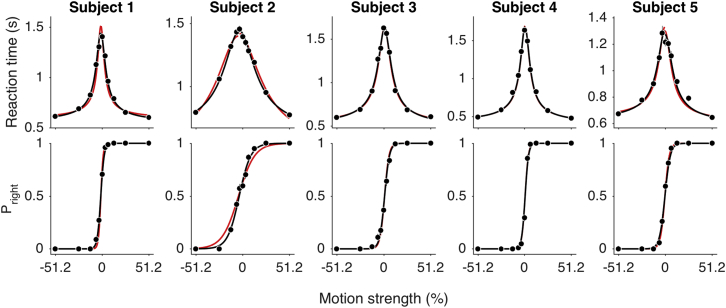
Reaction Times and Choices in the Free-Response TaskReaction times (top) and proportion of rightward choices (bottom) are plotted as a function of motion strength for the five subjects (mean ± SEM). Solid lines are drift-diffusion fits to RT and choice data (black; parameters in Table S1). Red curves show fits with κ fixed to the parameters from the tSD fits for each subject in the controlled-duration task (parameters in Table S2). See also Figure S5.